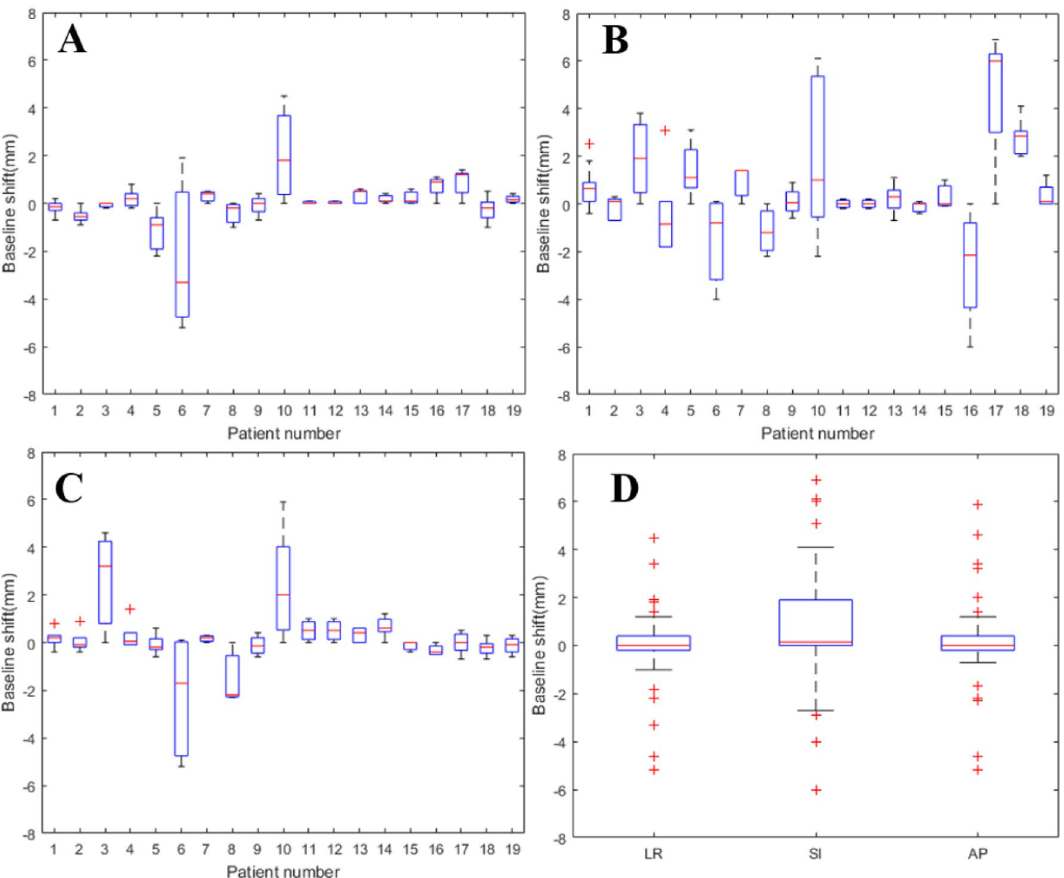
Figure 3. Inter-fractional tumor baseline shift in LR, SI and AP directions for 19 patients ( A : values in LR direction, B : values in SI direction, C : values in AP direction, D : statistic values in three